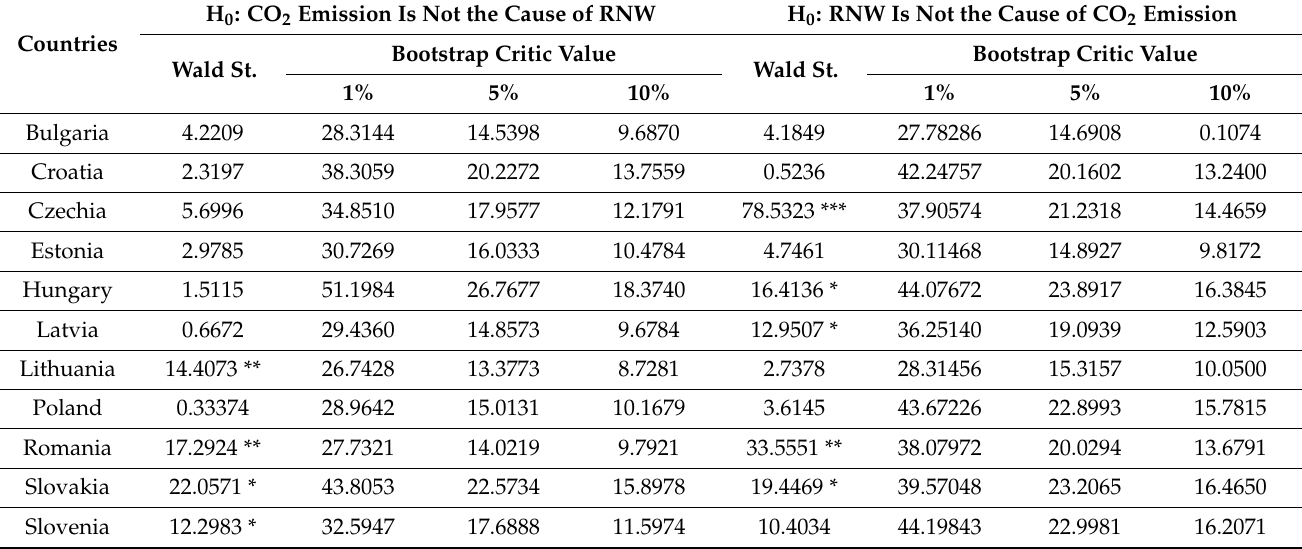
Table 8. Causality analysis between renewable energy and CO 2 emissions.